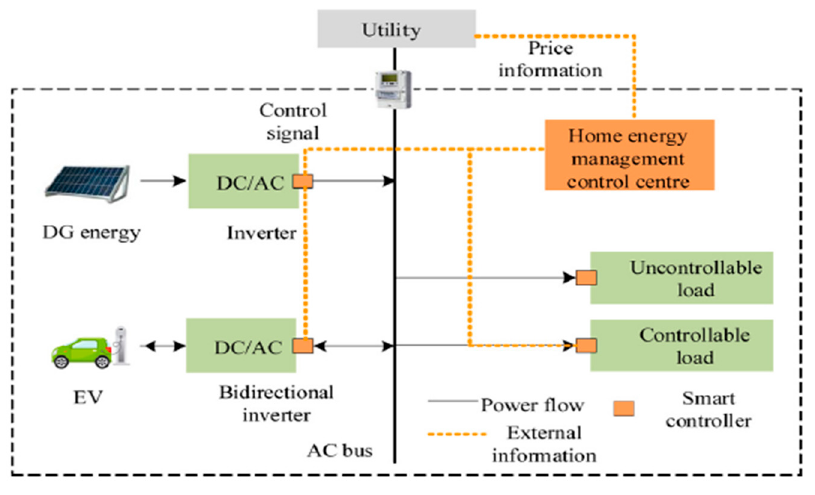
Figure 16. Studied HEMS structure [95].